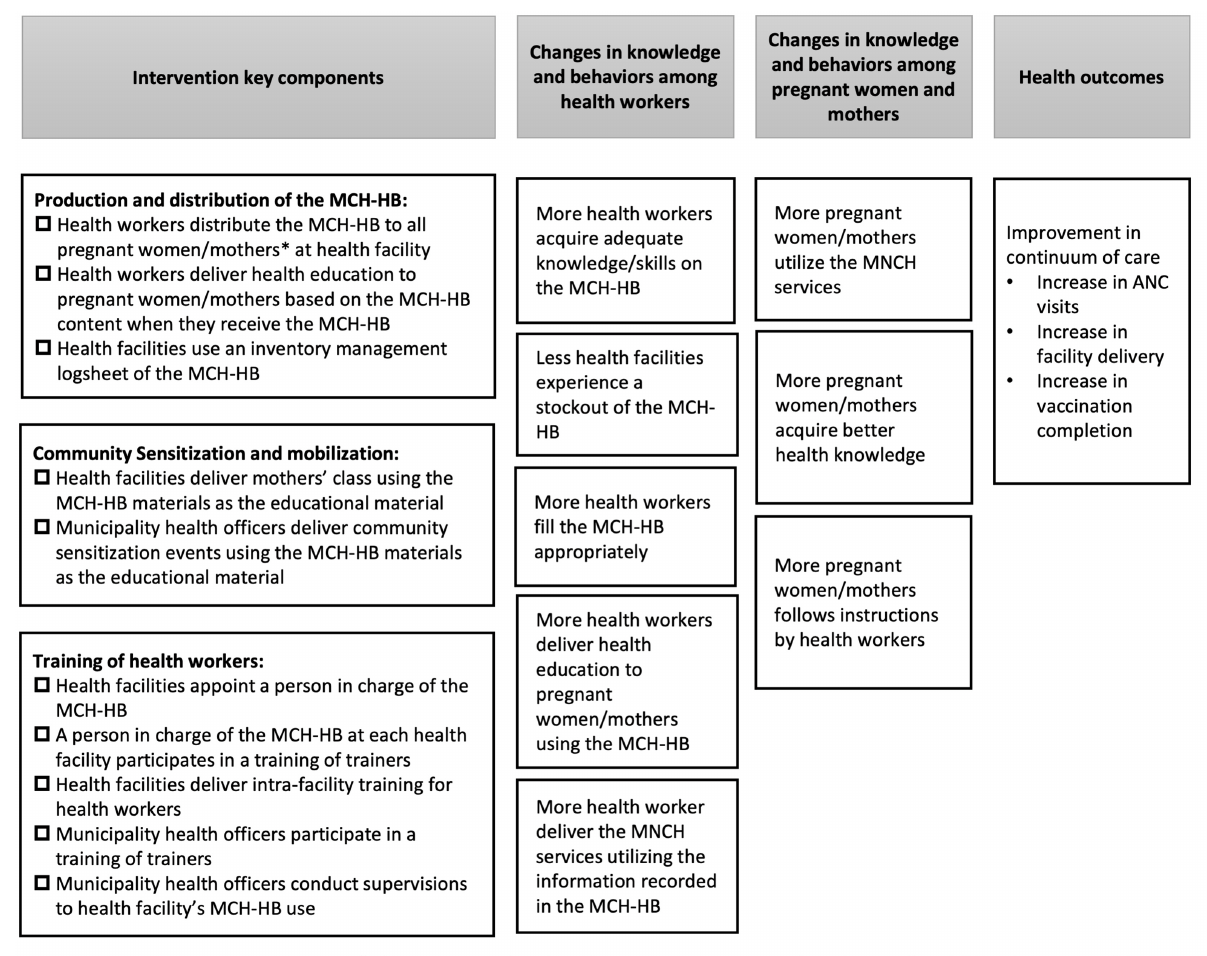
FIGURE 1 | Logic model for the MCH-HB to improve continuum of care among pregnant women and